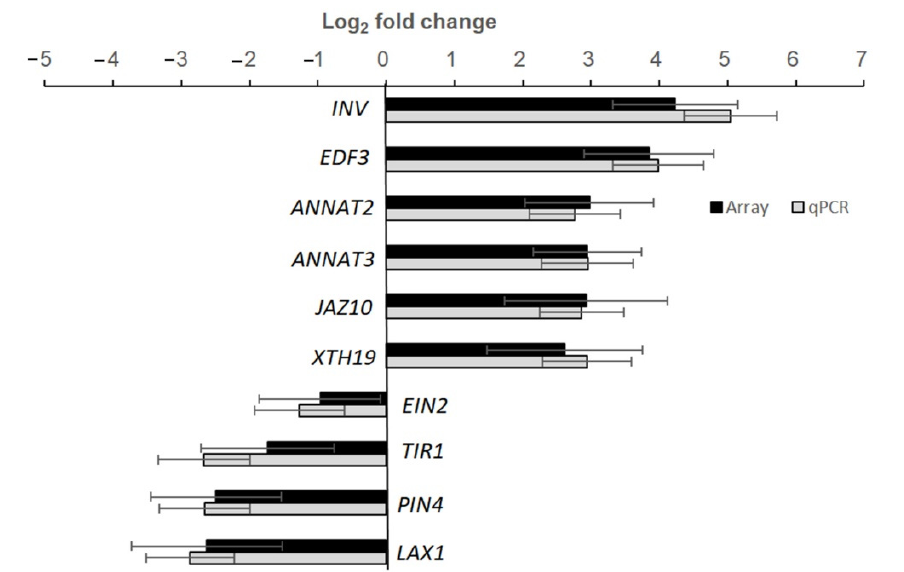
Figure 8. Relative transcript abundance changes in response to microgravity as compared to the ground control were analyzed by microarray and real-time qPCR using SYBR Green for detection. Microarray data for INV (AT3G17130), EDF3 (AT3G25730), ANNAT2 (AT5G65020), ANNAT3 (AT2G38760), JAZ10 (AT5G13220), XTH9 (AT4G30290), EIN2 (AT5G03280), TIR1 (AT3G62980), PIN4 (AT2G01420), and LAX1 (AT5G01240) for an average of four independent technical replicates. Real-time qPCR with isoform-specific primers for those genes was performed on a fourth independent technical replicate using the same samples as in the microarray analysis above. Error bars indicate the standard deviation of the mean.